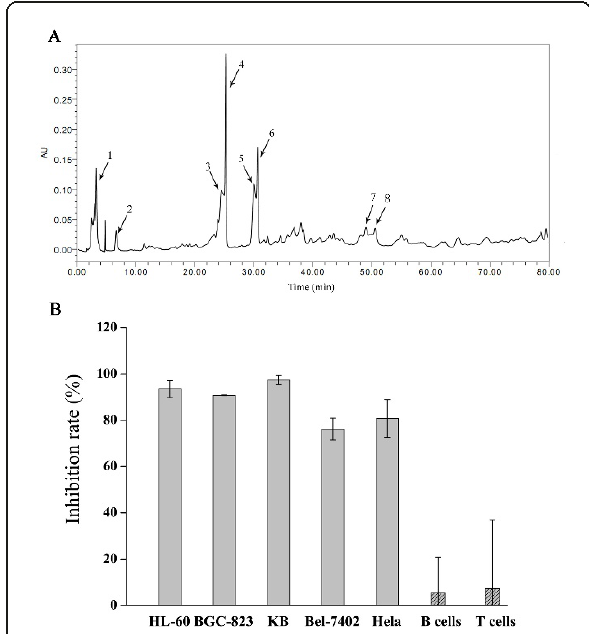
Figure 1 Chemical composition and cytotoxic activity of TC extract . (A) Peaks: 1, taxine A (5.00%); 2, 10-DAB III (1.45%); 3, 9- hydroxyl-13-acetylbaccatin III (9.38%); 4, 7-xyl-10-DAT (9.63%); 5, baccatin III (8.32%); 6, 10-DAT (6.31%); 7, cephalomannine (2.67%); 8, paclitaxel (2.25%). (B) Differences in TC extract cytotoxicity in 5 human cancer cell lines and normal mouse spleen B and T lymphocytes. The cell growth inhibition was quantified by the MTT assay. Cells were treated with 10 μ g/ml TC extract for 72 h. The data shown are from 3 independent